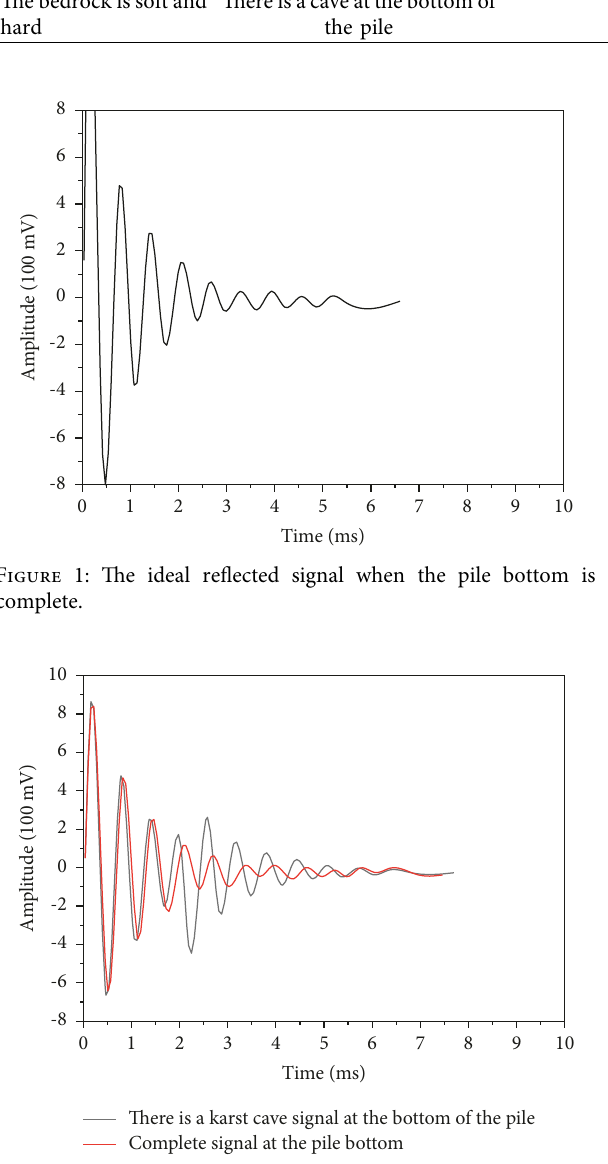
Figure 2: The ideal reflection signal when there is a karst cave at the bottom of the pile.